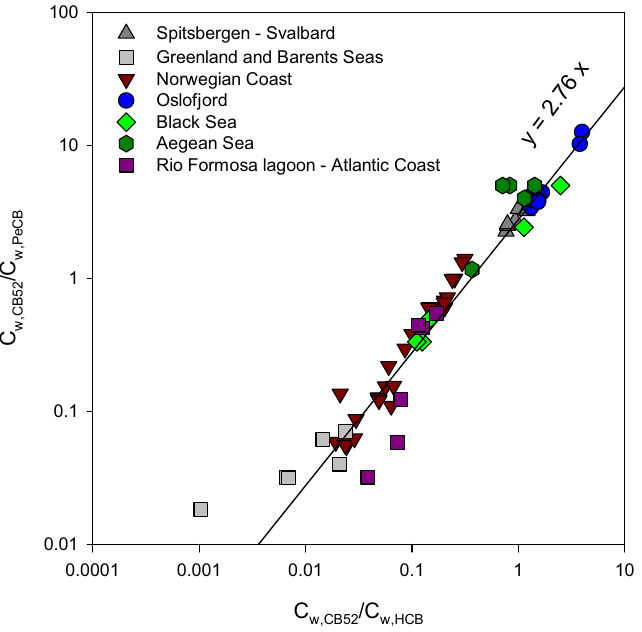
Figure 4. Benchmarking of freely dissolved concentrations of CB52 with those estimated for HCB and PeCB at all marine sampling sites. Note that every datapoint is plotted on the graph. Sites closest to the top right corner exhibit highest CB52 concentrations while those closest to the bottom left corner indicate lowest CB52 concentrations. Datapoints deviating from the diagonal reference line indicate either a PeCB contamination (towards the top left corner) or an HCB contamination (towards the bottom right